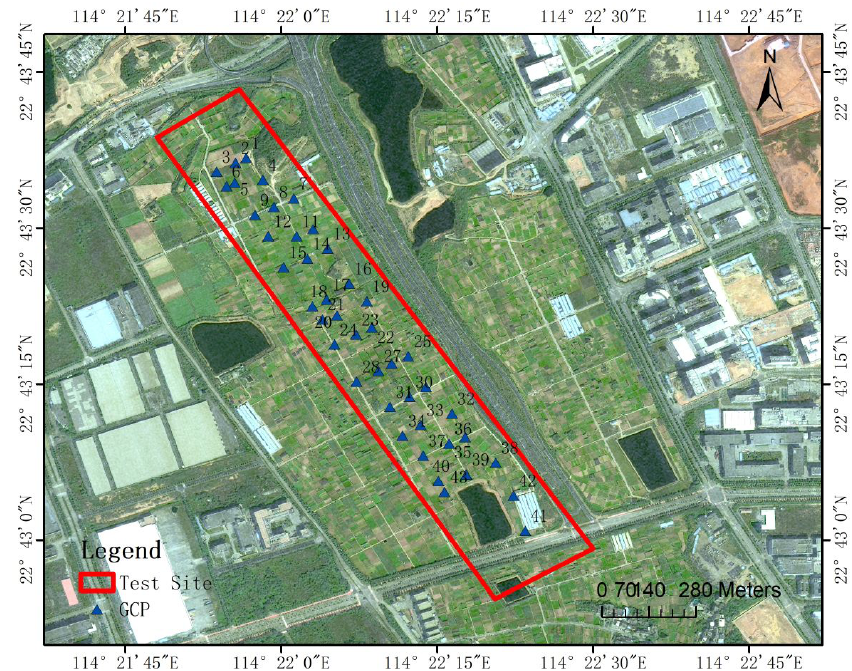
Figure 14. Ground control points in the second test site